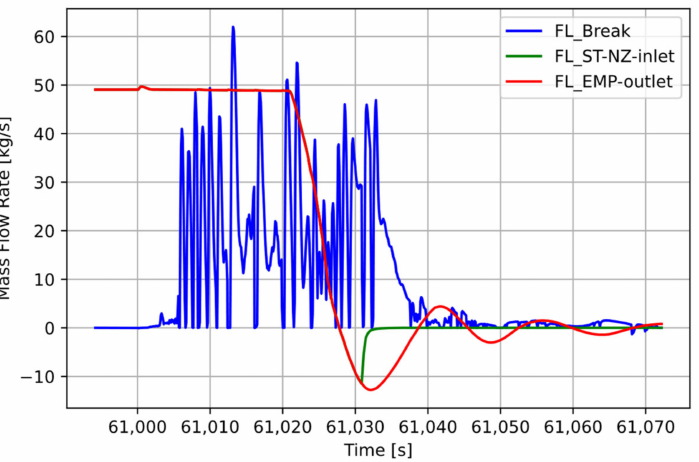
Figure 6. Mass flow rate for selected flow paths for break (FL801), removable ST-NZ inlet (FL852), and EMP (FL350).